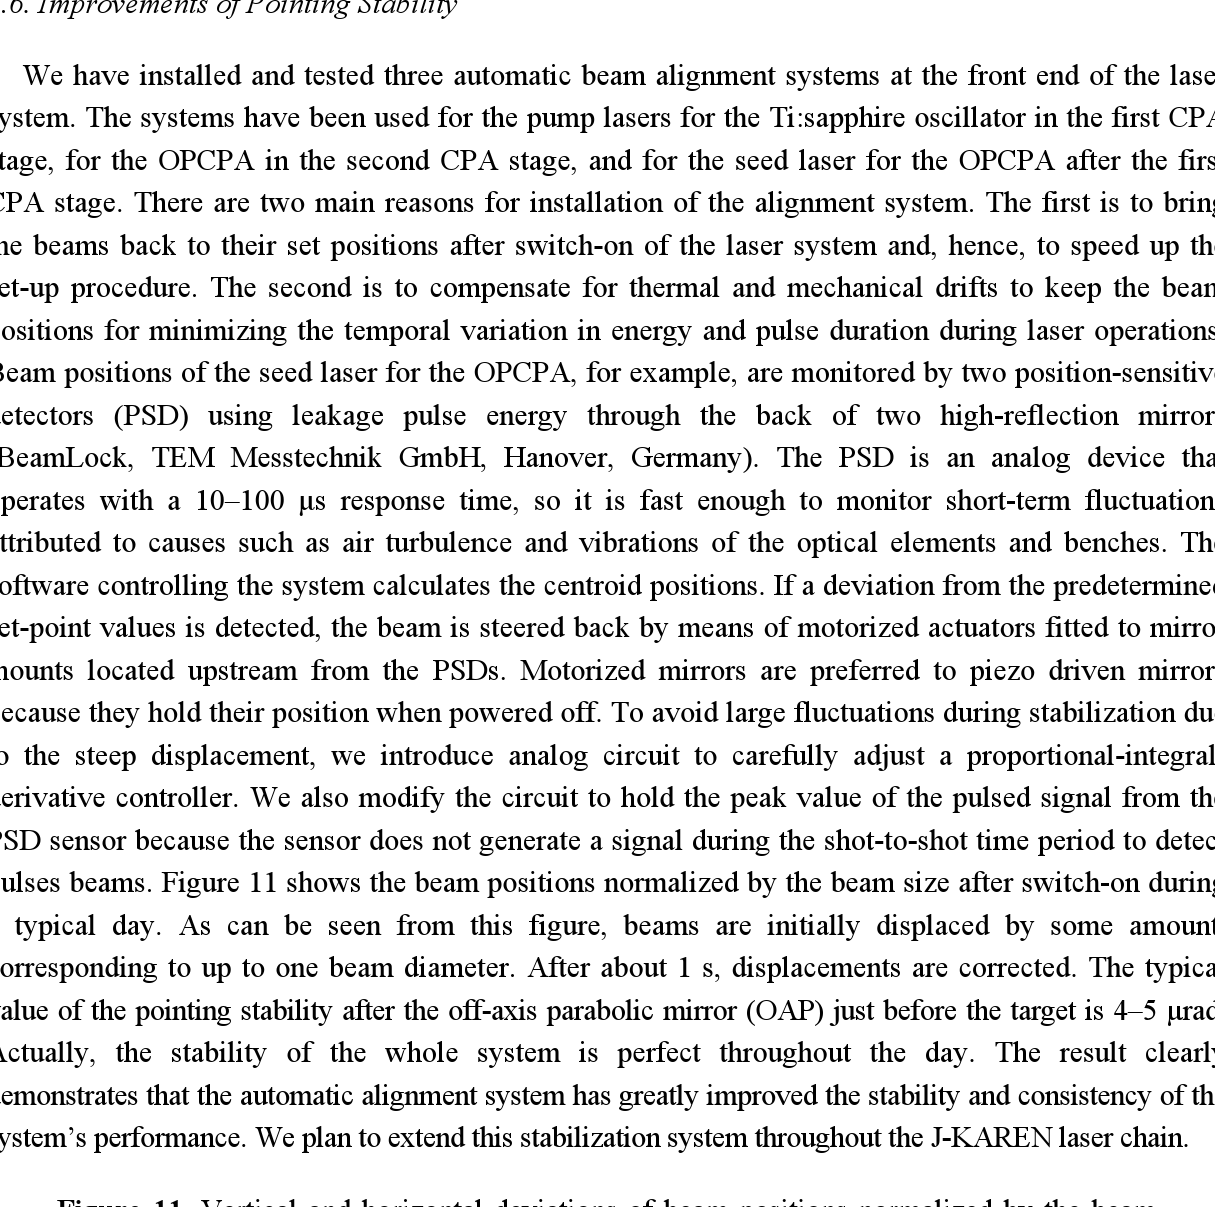
Figure 11. Vertical and horizontal deviations of beam positions normalized by the beam size after switch-on of the automatic beam alignment